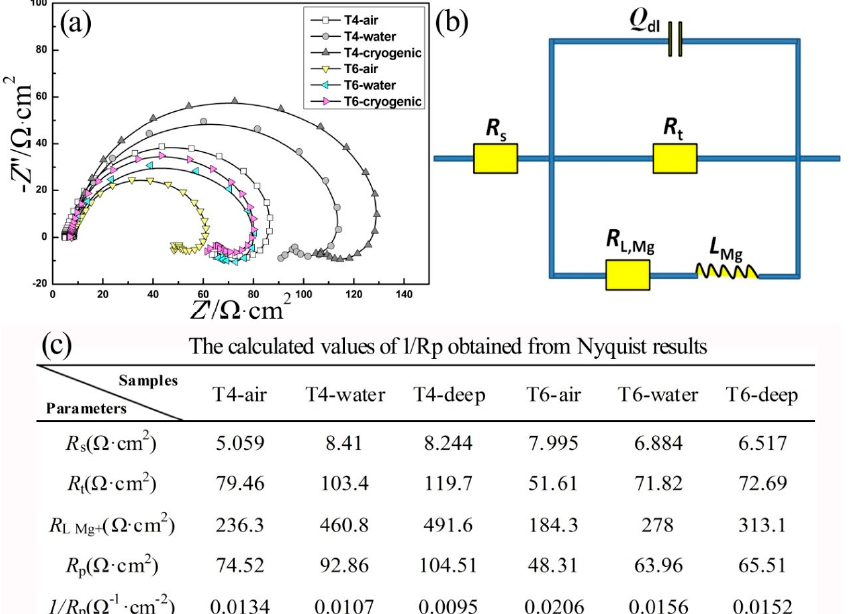
Figure 13. ( a ) Nyquist diagrams; ( b ) equivalent circuit; and ( c ) calculated values of Mg-7Y-1.5Nd samples in 3.5% NaCl at 25 ± 1 °C.